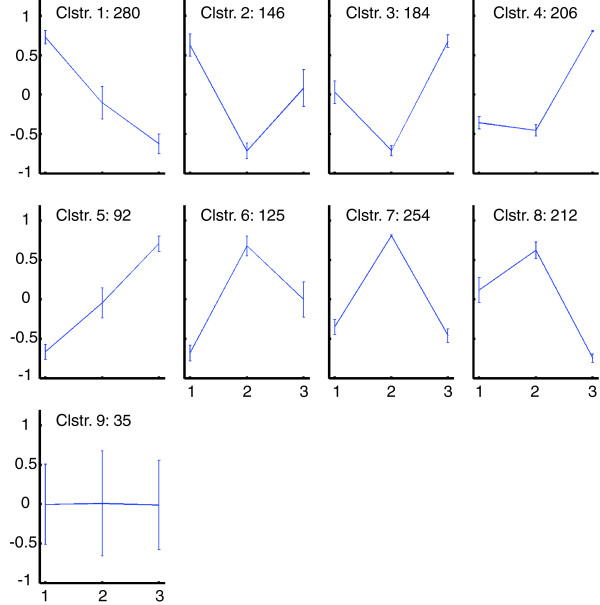
Representation of the eight clusters of genes identified. The numbers of genes in each cluster are as follows: 280 in cluster 1, 146 in cluster 2, 184 in cluster 3, 206 in cluster 4, 92 in cluster 5, 125 in cluster 6, 254 in cluster 7, and 212 in cluster 8. The x-axis represents the different carbon sources investigated: 1, glucose; 2, ethanol; and 3, glycerol. The y-axis represents normalized intensities, according to Grotkjær and coworkers [19]. Cluster 9 contains discarded genes, with low assignment to any of the other clusters.